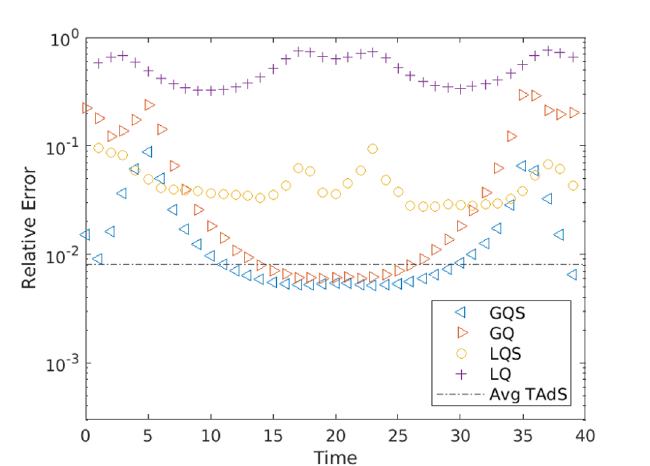
Figure 14. Relative boundary error as a function of time for a free fermion system after a quench. GQS, GQ, LQS, LQ denote global quench with smoothing, global quench without smoothing, local quench with smoothing, and local quench without smoothing, respectively. Dashed line marks the average relative error for the thermal AdS entropy